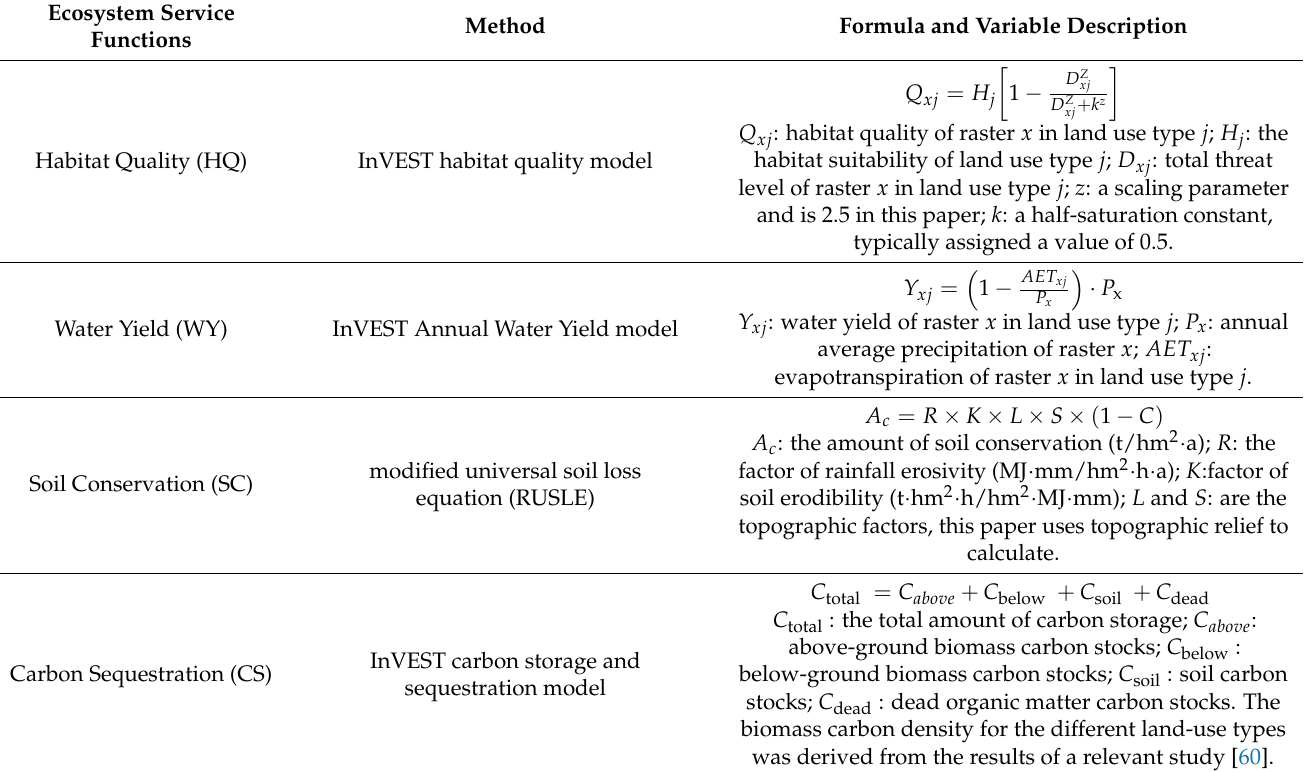
Table 1. Methods and calculation processes for ecosystem service functions.